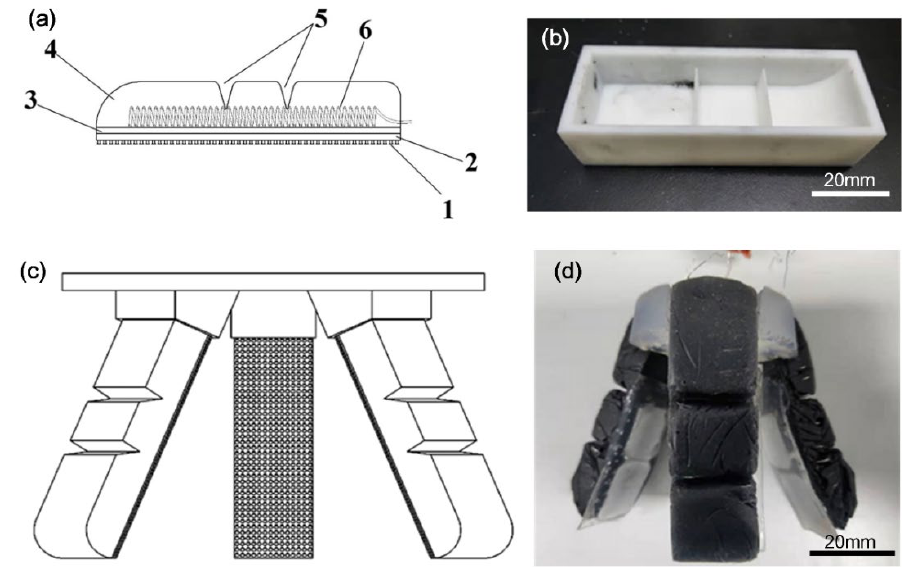
Figure 1. Design and fabrication of soft gripper. ( a ) Schematic model with number 1 to 6 indicating the dry adhesive microstructures (1), PDMS supporting layer (2), TPU layer (3), ecoflex–rGO composite layer (4), V-shape joints (5) and electric wires (6), respectively. ( b ) 3D printed mold for artificial finger. ( c ) Schematic illustration of assembly and ( d ) photo of the as-prepared soft gripper assembled from three artificial fingers.